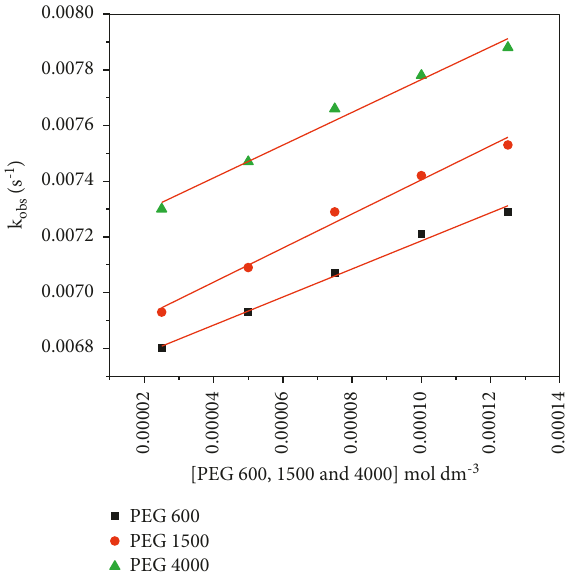
Figure 5: k obs versus [PEG 600, 1500 and 4000] at the following reaction conditions: [Ce (IV)] � 0.003mol dm − 3 , [Maltose] � 0.03mol dm − 3 , and [H 2 SO 4 ] � 0.40 moldm − 3 at 298 K.